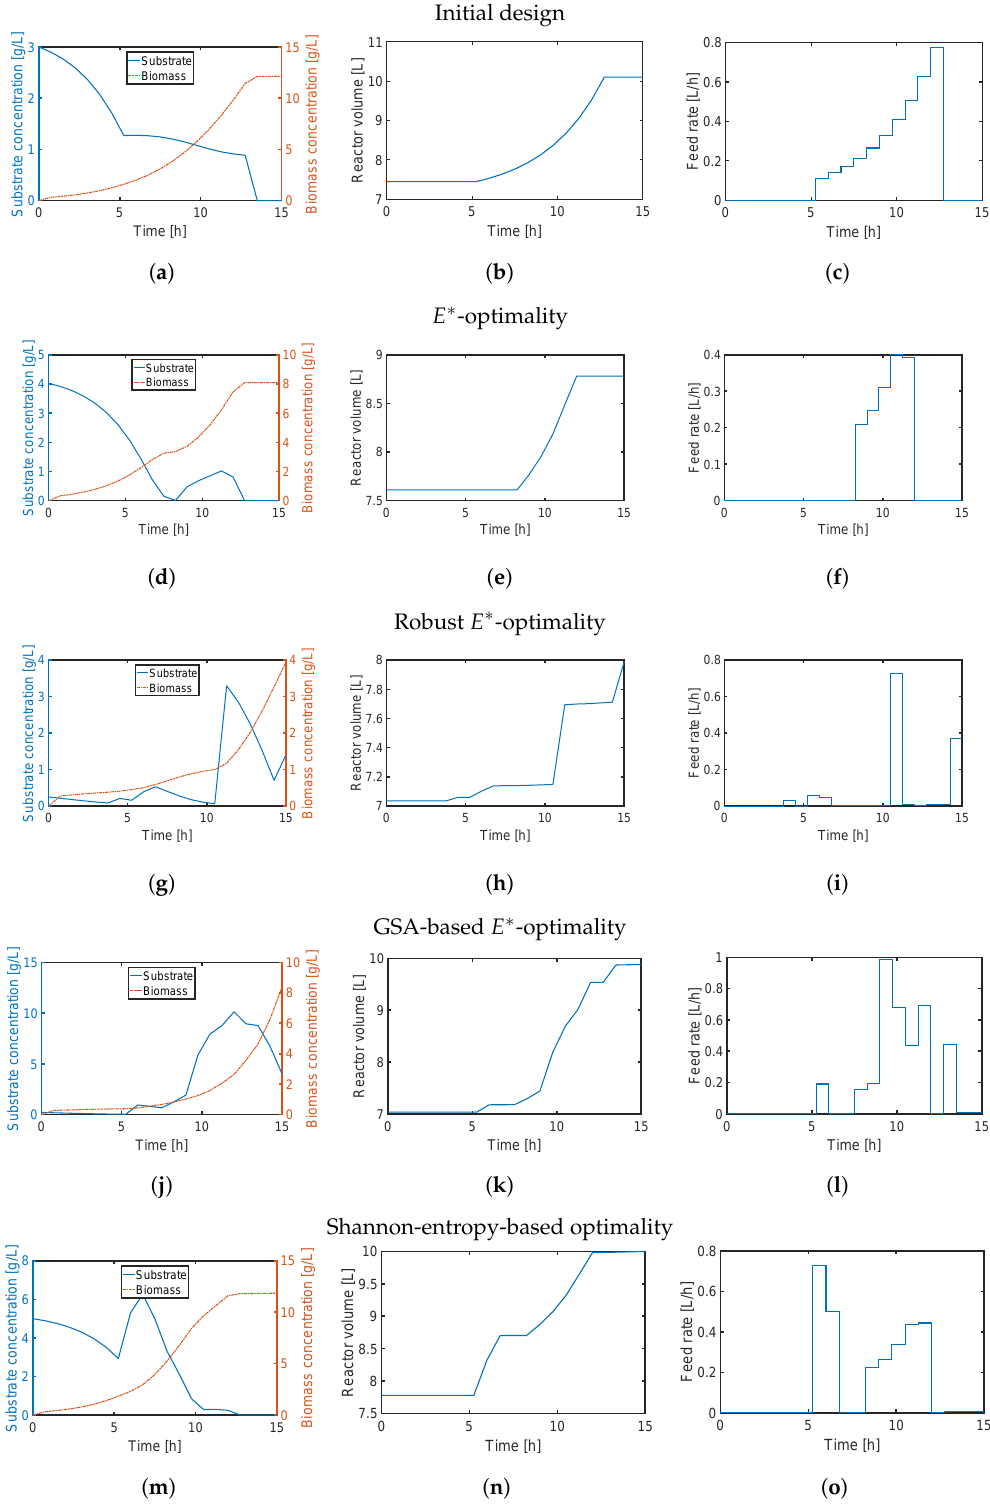
Figure 8. MB-OED results showing the evolution of biomass and substrate concentration ( left ), and volume of the reactor ( middle ) based on the optimized feed rate ( right